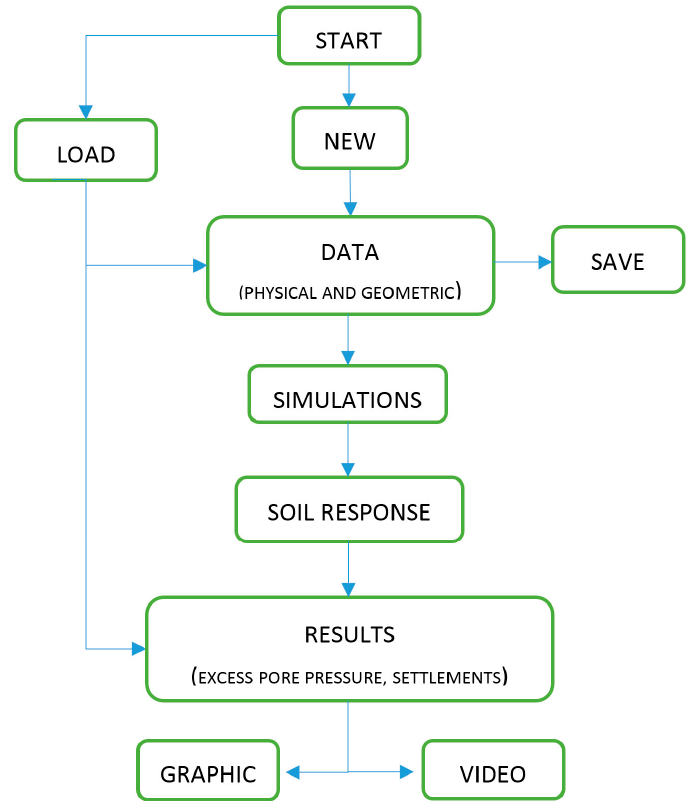
Figure 5. Operating scheme of SICOMED_2018.